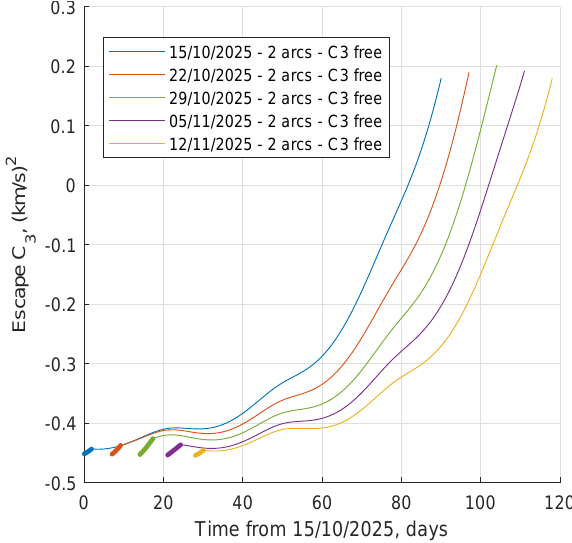
Figure 5. Spacecraft energy over time for reference departure dates from SEL2.